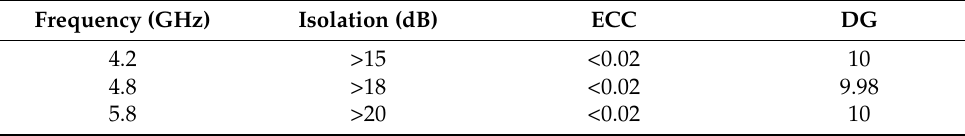
Figure 13. ECC of the four-element stacked MIMO antenna. Table 2. Parameters of the proposed MIMO